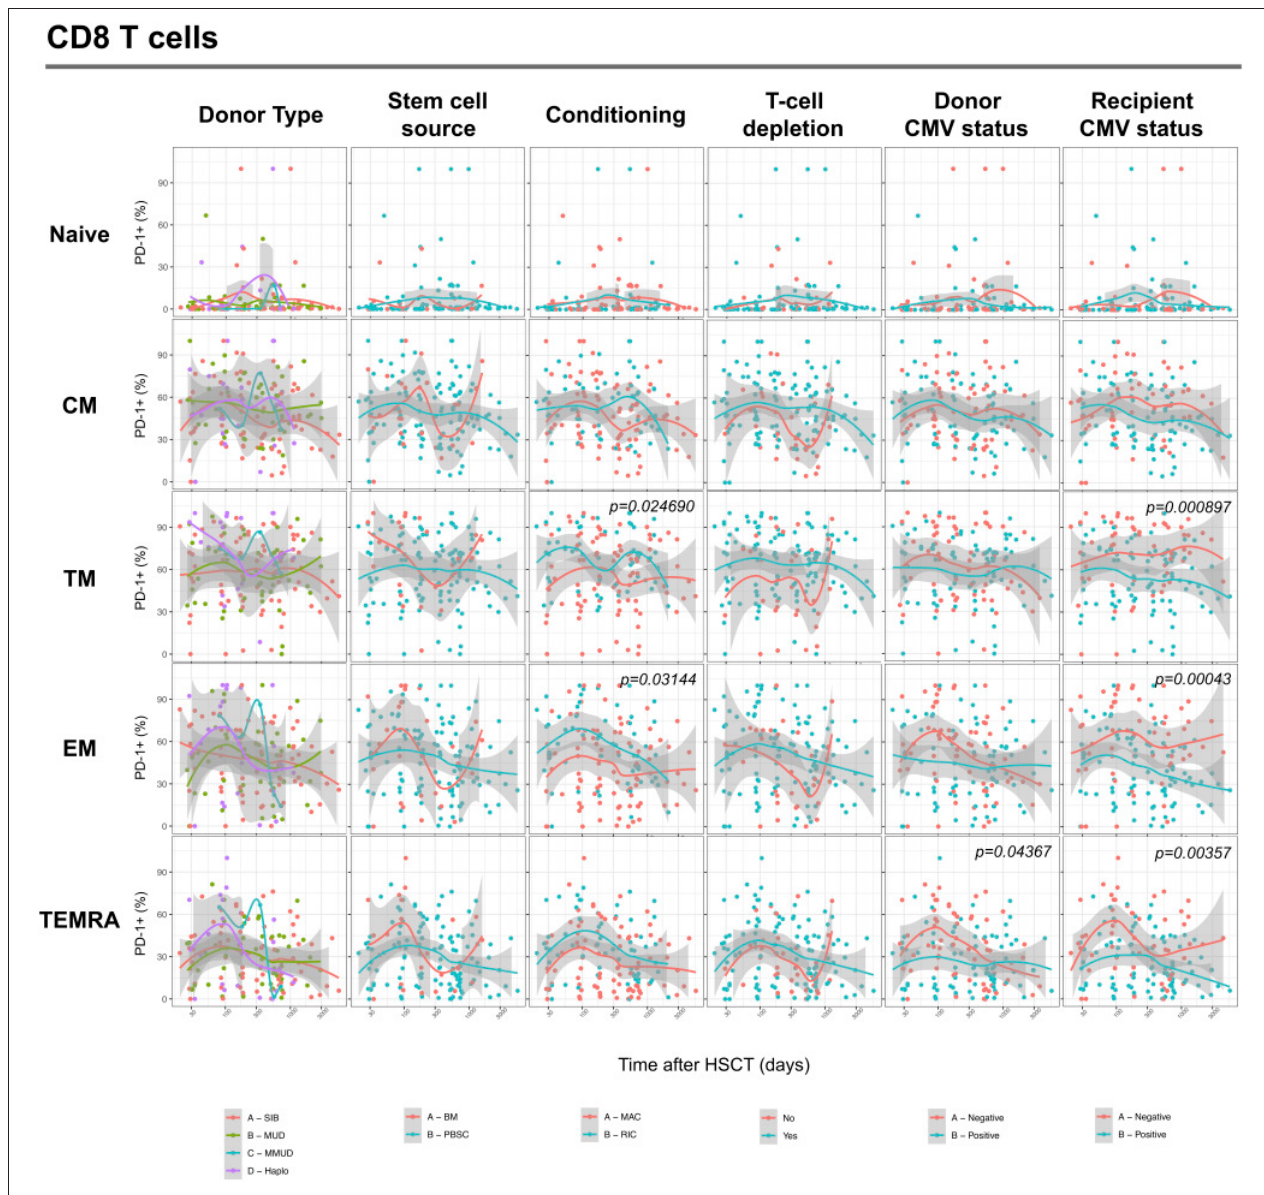
FIGURE 6 | Impact of clinical factors on PD-1 expression at CD8T cell subsets surface after allogeneic HSCT. Comparison of PD-1 expression on CD8T cell subsets from HSCT recipients depending on donor type, stem cell source, conditioning, T-cell depletion and donor/recipient CMV status. The p- values resulting from the multivariable linear regression analysis are indicated when